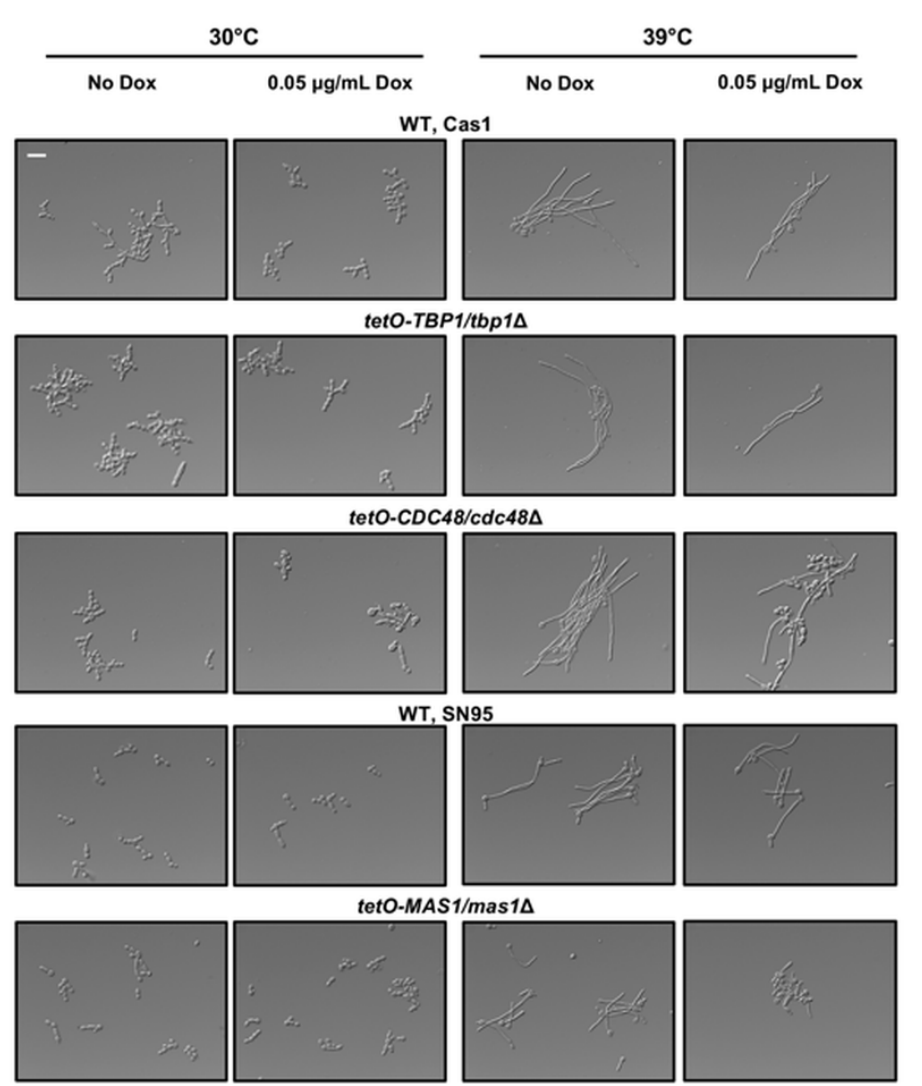
FIGURE 4: Mas1 and Cdc48 contribute to filamentation in re- sponse to elevated temperature. The indicated doxycycline- repressible conditional expression strains and their respective wild- type counterparts were cultured in the absence or presence of 0.05 μg/mL doxycy- cline (Dox) in YPD at 30°C for 16 hours. Cells were subcultured under the same condi- tions and grown at 30°C or 39°C for 3 hours before imaging. Scale bar